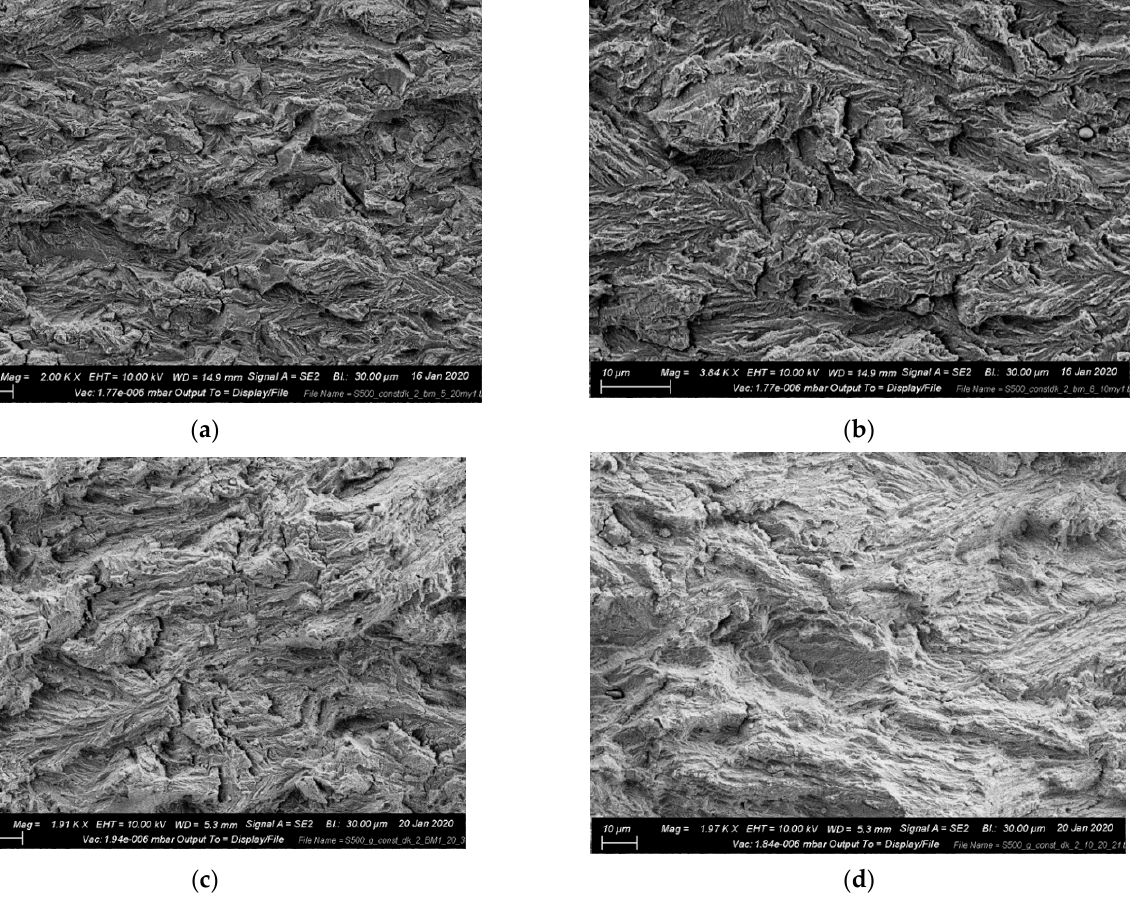
Figure 13. Fracture surfaces of fatigue crack growth rate test specimens with crack located in the base material at ( a ) room temperature, and ( b ) − 100 °C, and with crack located in the weld metal at base material at ( a ) room temperature, and ( b ) − 100 ◦ C, and with crack located in the weld metal at ( c ) room temperature, and ( d ) − 100 °C. ( c ) room temperature, and ( d ) − 100 ◦